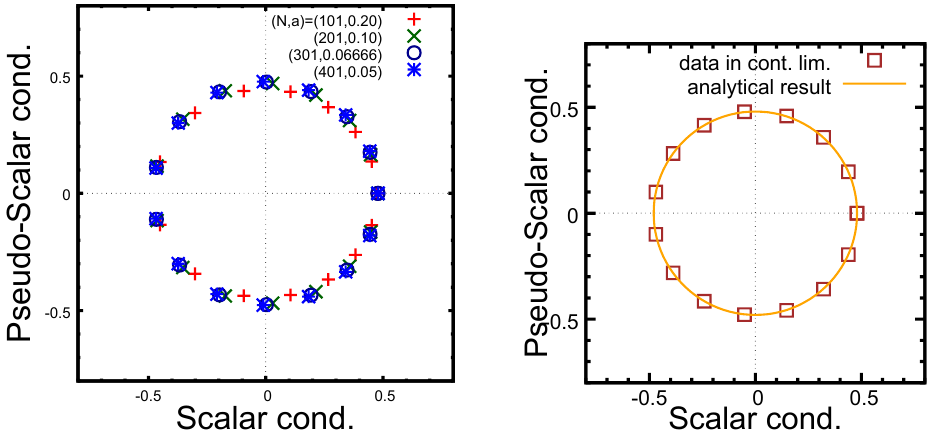
Figure 5 . (Left): θ dependence of the scalar and pseudo-scalar condensate at n = ( N − 1) / 2 site for m lat = 0 . 00 in a fixed volume L = ( N − 1) a = 20 . (Right): the data in continuum limit (square symbol) and the result of mass perturbation theory.